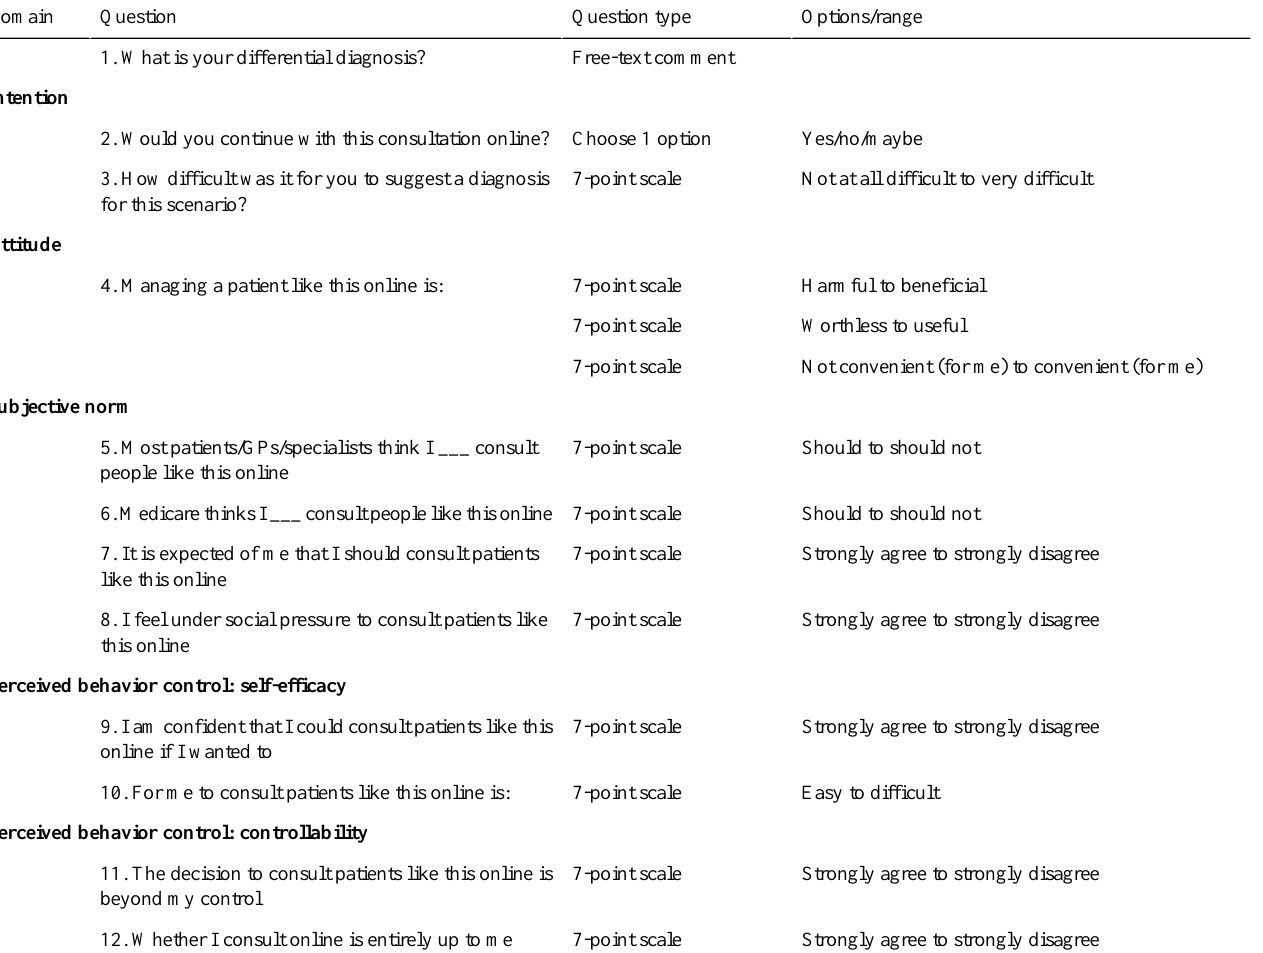
Table 2. Questions for participants after each video.